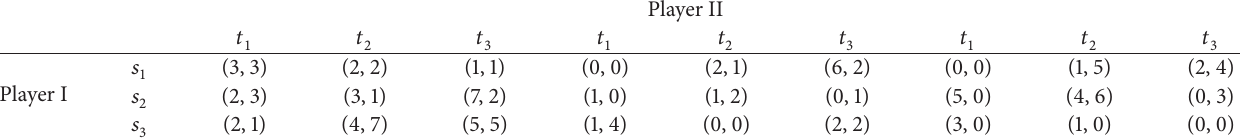
Table 3: Game with